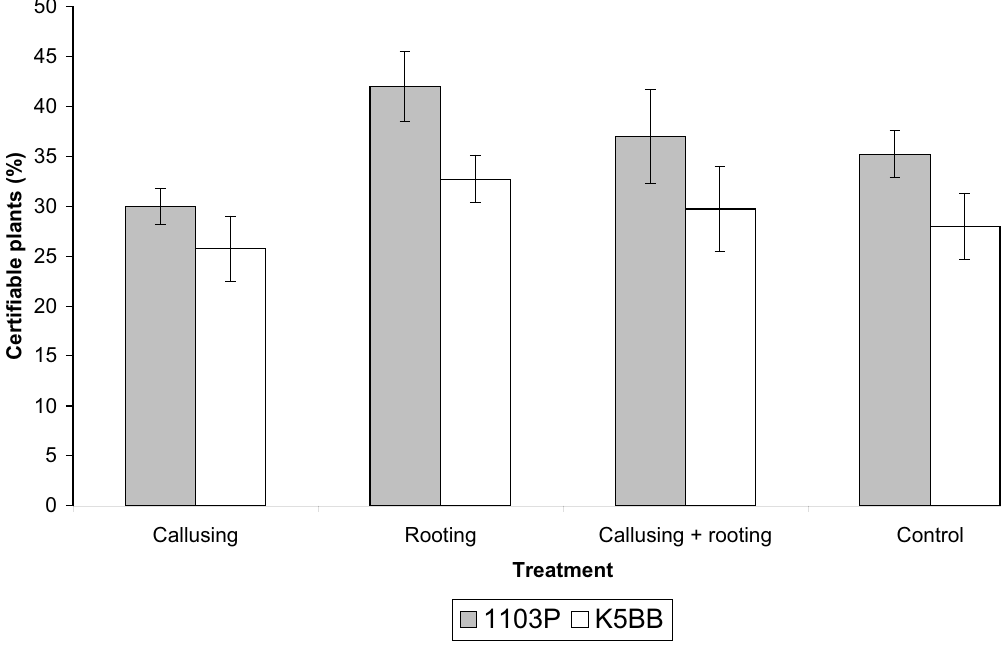
Fig. 3. Mean percentage of certifiable Trebbiano romagnolo plants on 1103P or K5BB treated with Trichoderma at various nursery-vine growth stages. Bars represent standard